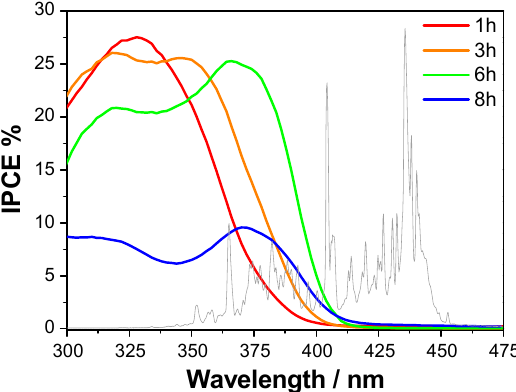
Figure 5. Effect of the deposition time on the incident photon to current efficiency (IPCE) curves of the TiO 2 -based photoelectrodes as a function of the incident wavelength. The emission spectrum of the Hg vapor lamp used as light source in separate H 2 and O 2 evolution photocatalytic tests is also shown (gray line).